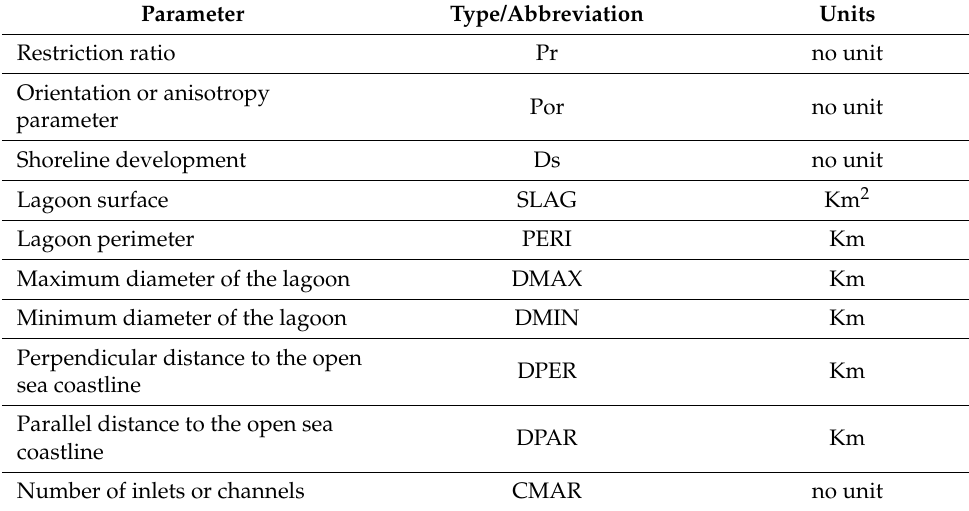
Table 2. Morphometric lagoon parameters (modified after ref.